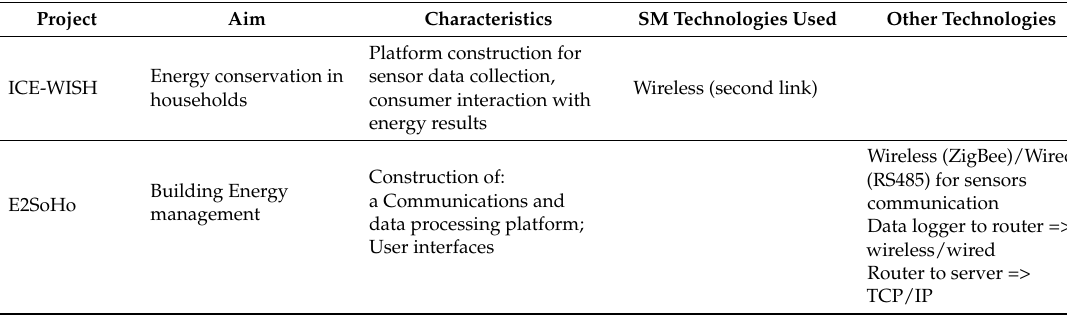
Table 5. Summary of projects focused on ICT for in-home and building energy